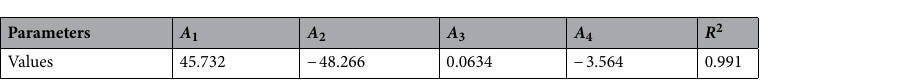
Table 2. The best-fitted parameters of mater curve of S 0 for